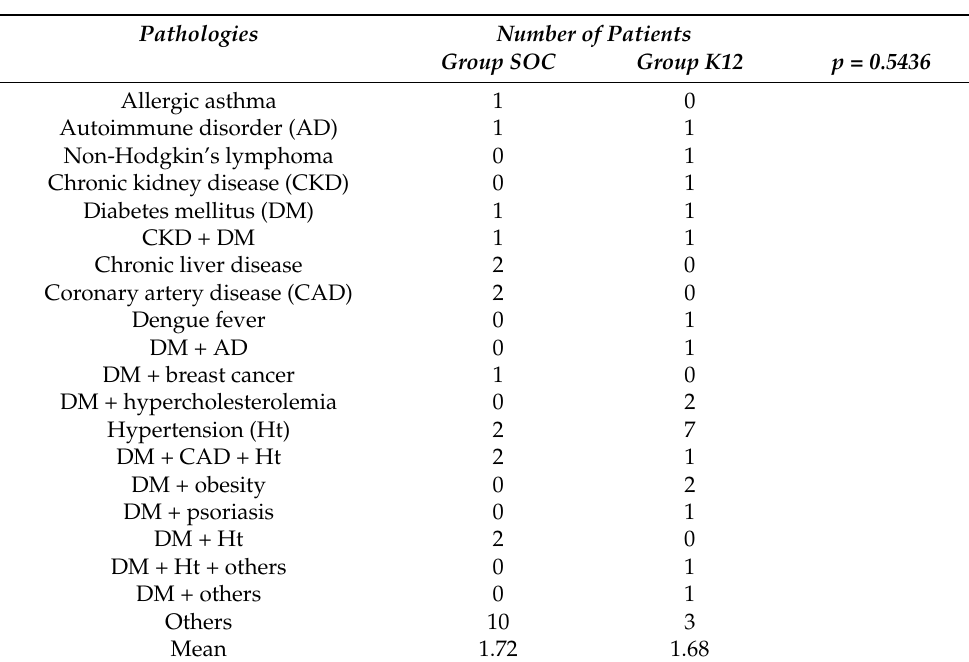
Table 2. Comorbidities of the enrolled patients. Pathologies Number of Patients Group SOC Group K12 p = 0.5436 Allergic asthma